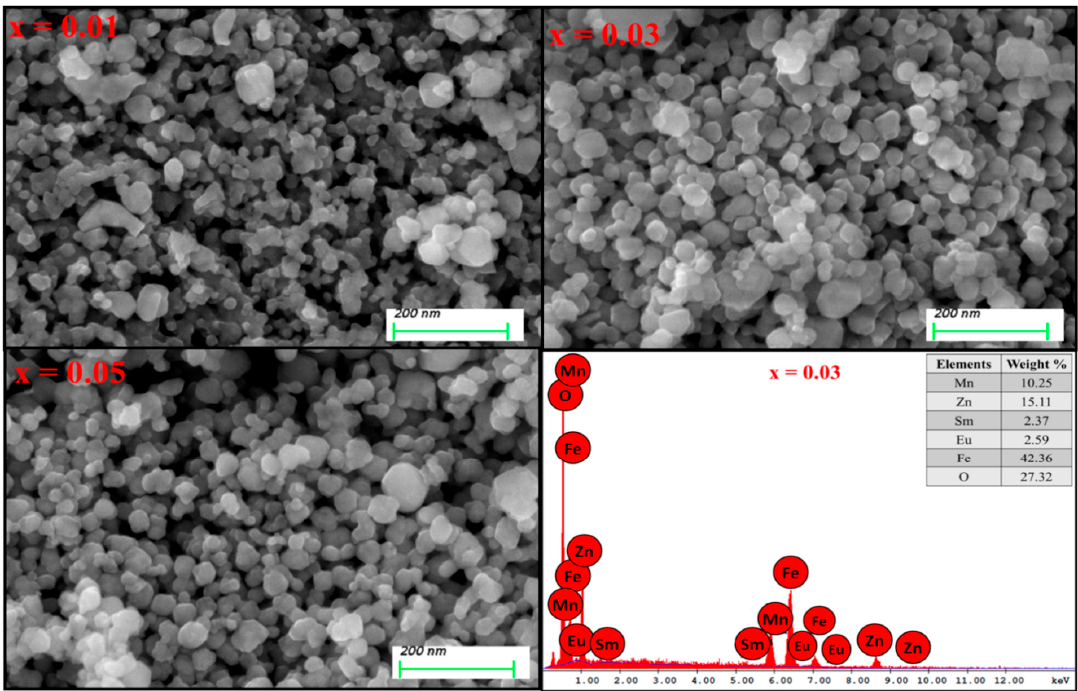
Figure 2. SEM of Mn 0.5 Zn 0.5 Eu x Sm x Fe 1.5 − 2x O 4 for x = 0.01, 0.03, and 0.05 and EDX x = 0.03 NPs.